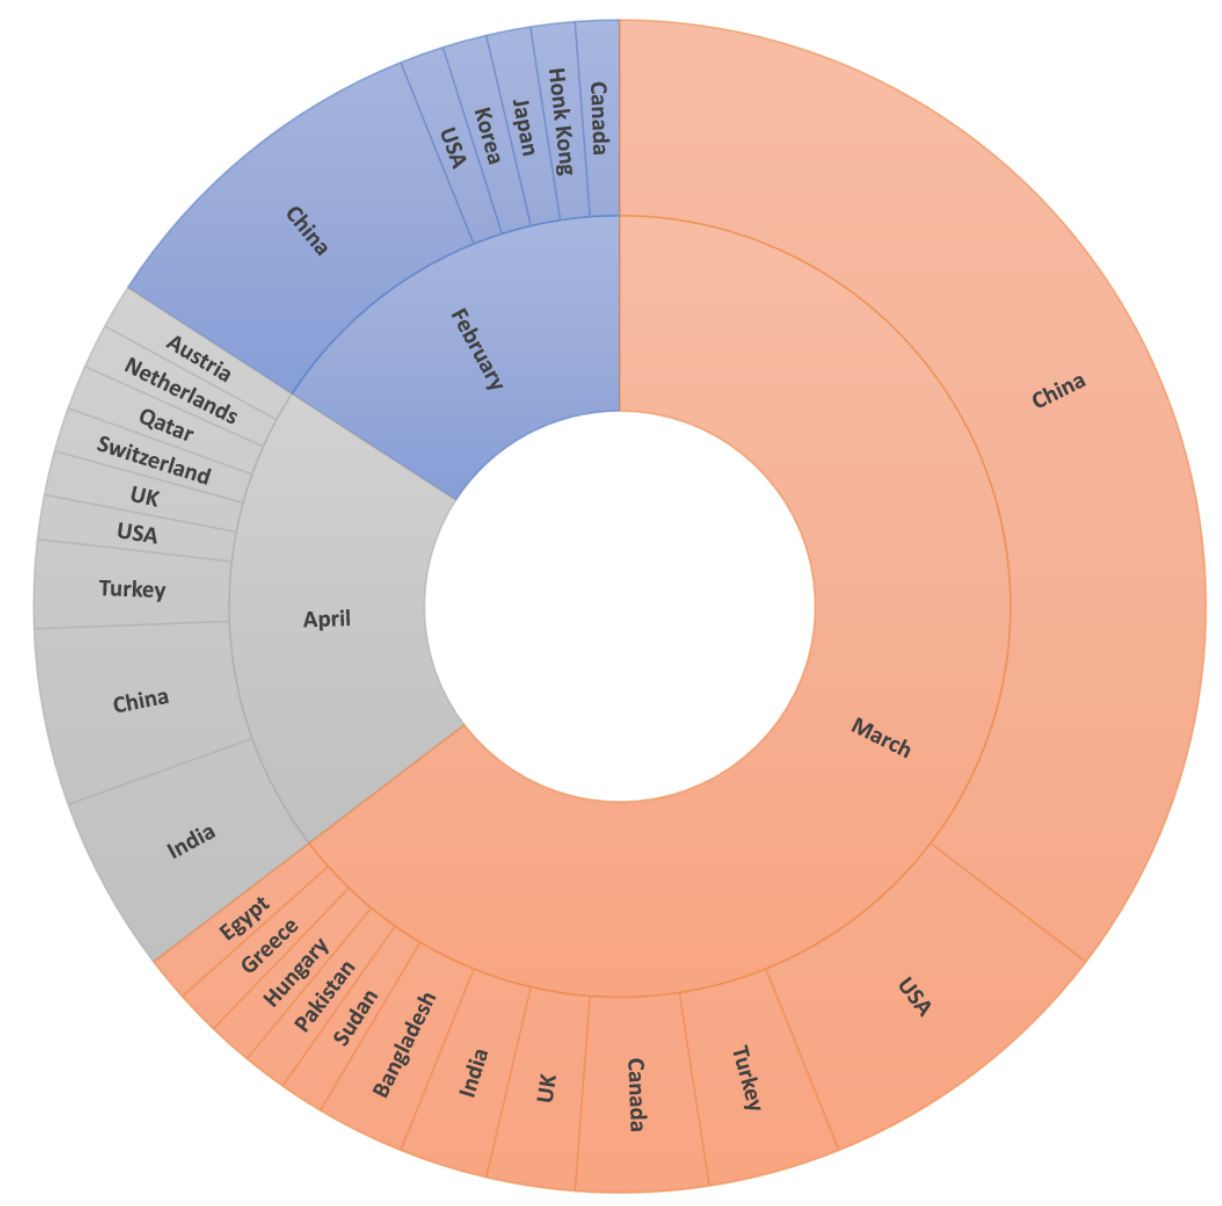
Figure 2. Publications by months and